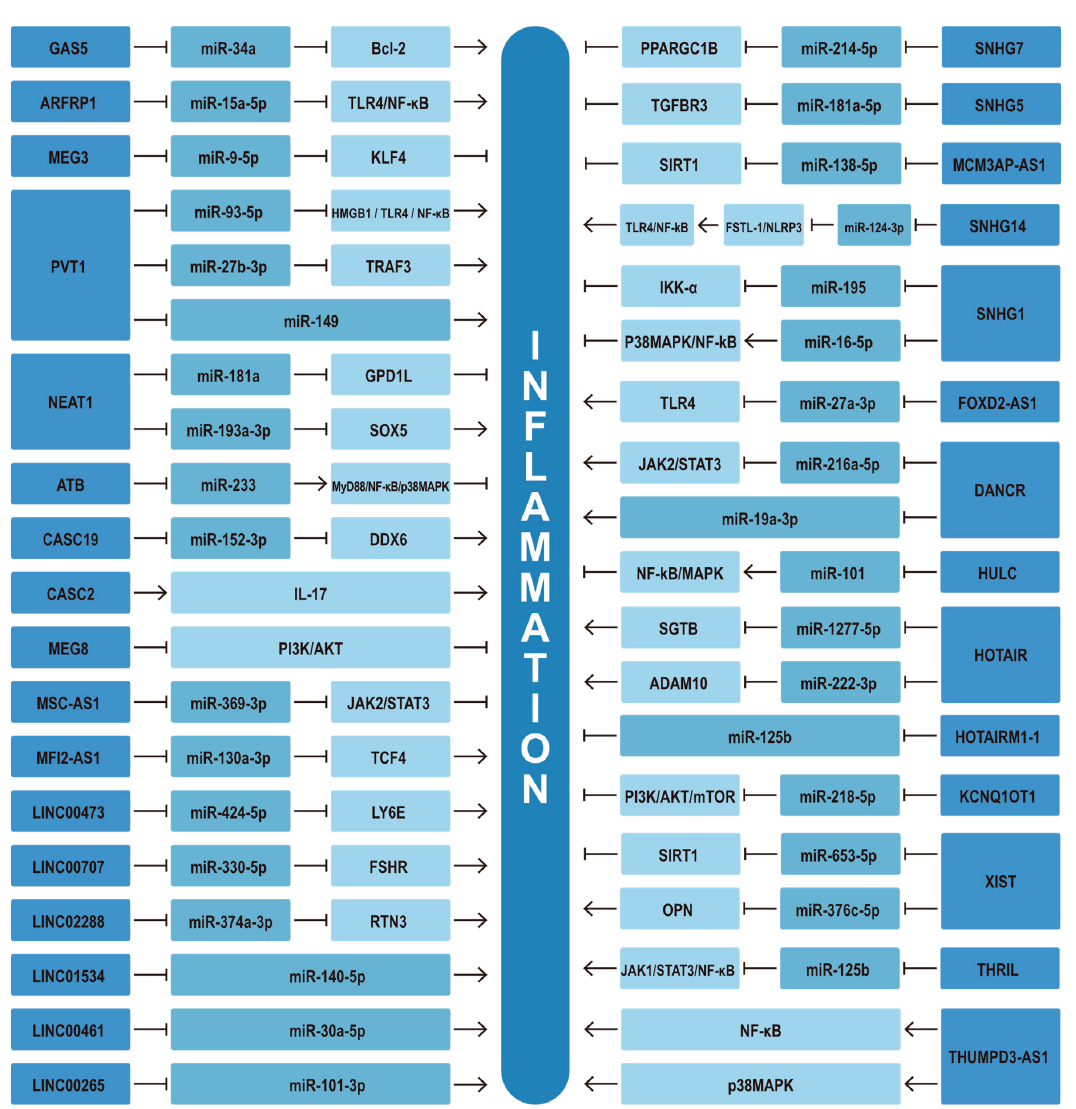
miR-181a-5p/TGFBR3 axis. Similarly, SNHG7 [42], as a ceRNA, was shown to activate